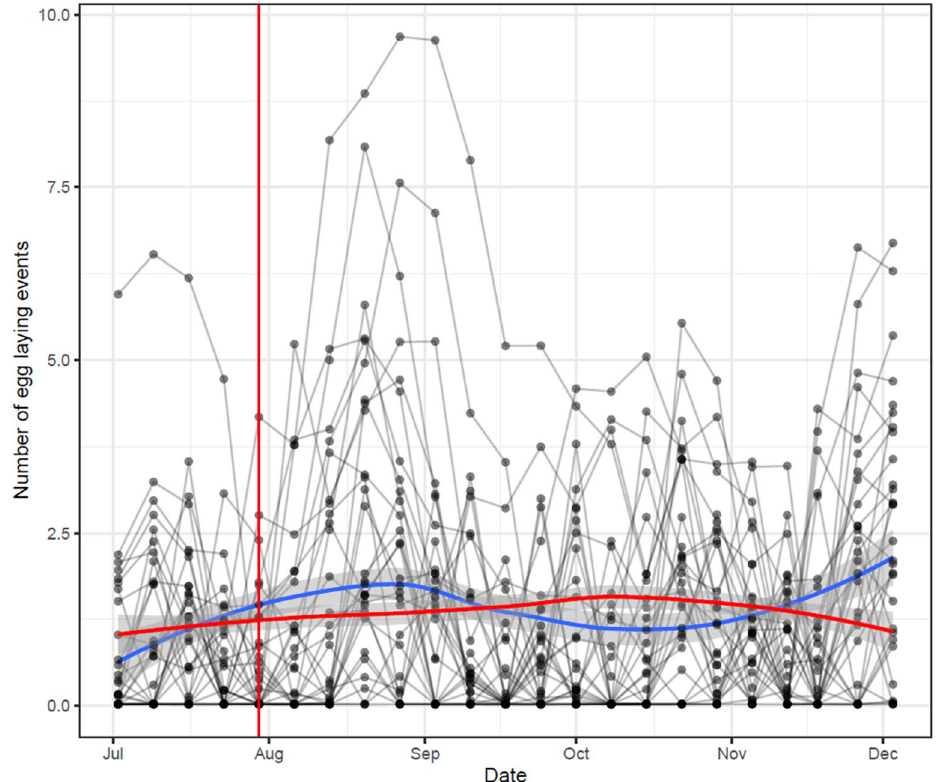
Figure 4. The inferred number of egg laying events in the index ovitraps in the Treatment blocks. The inferred number of egg-laying events over time for each index ovitrap in the Treatment blocks are plotted as lines. The index ovitraps were measured for 3 weeks before additional ovitraps were placed in the Treatment blocks (therefore increasing the number of removed eggs in those blocks). The red vertical line indicated the time at which new ovitraps were placed. The red and blue horizontal lines represent the loess curves for the index ovitraps in the Treatment block and the ovitraps in the combined control group (Control and Vector blocks),